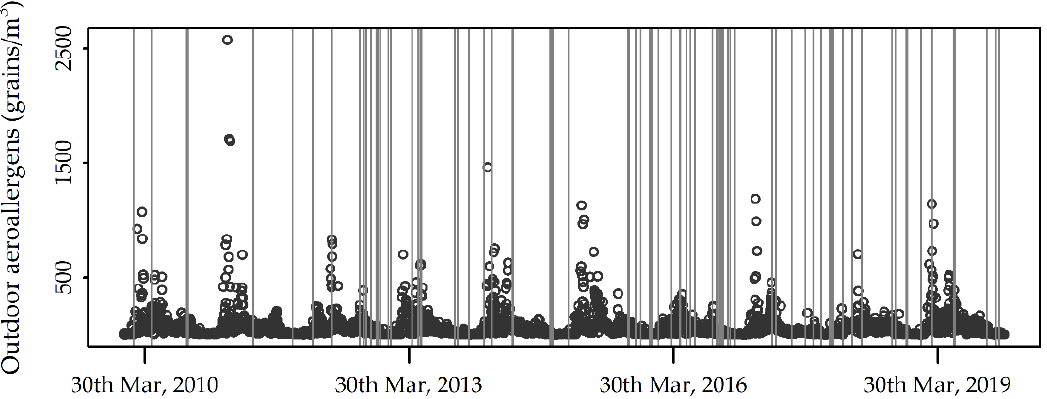
Figure 2. Daily total outdoor allergen counts recorded during the study period (points), with bars superimposed to highlight the case days. Based on the BIC, unadjusted models with a linear function in the lag yielded the best trade-off between goodness-of-fit and model parsimony. A 10-grains/m 3 increase in the total outdoor aeroallergen concentration was significantly associated with an increased risk of asthma or asthma-like symptom admission at lag 0 (OR = 1.054, 95% CI: 1.011–1.098), with a smaller effect at lag 1 (OR = 1.037, 95% CI: 1.008–1.067) and lag 2 (OR = 1.021, 95% CI: 1.003–1.039) (Table 3). Concerning single aeroallergens, significant effects were only observed for Alternaria (OR = 1.140, 95% CI: 1.020, 1.275 at lag 0) (Table S1). Table 3. Acute effects of outdoor aeroallergen counts on the risk of admissions overall and by child subgroup: odds ratios (10-grains/m 3 increase) and 95% confidence intervals through the conditional logistic regression models. Significant effects are in bold.